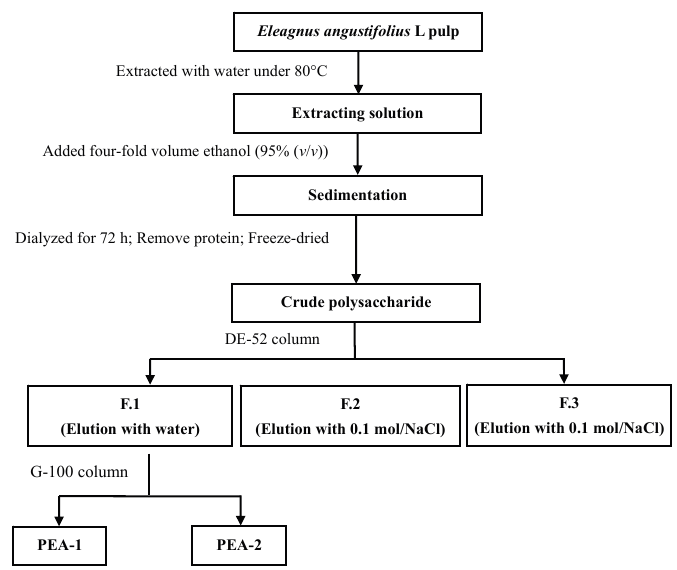
Figure 1. Extraction and isolation